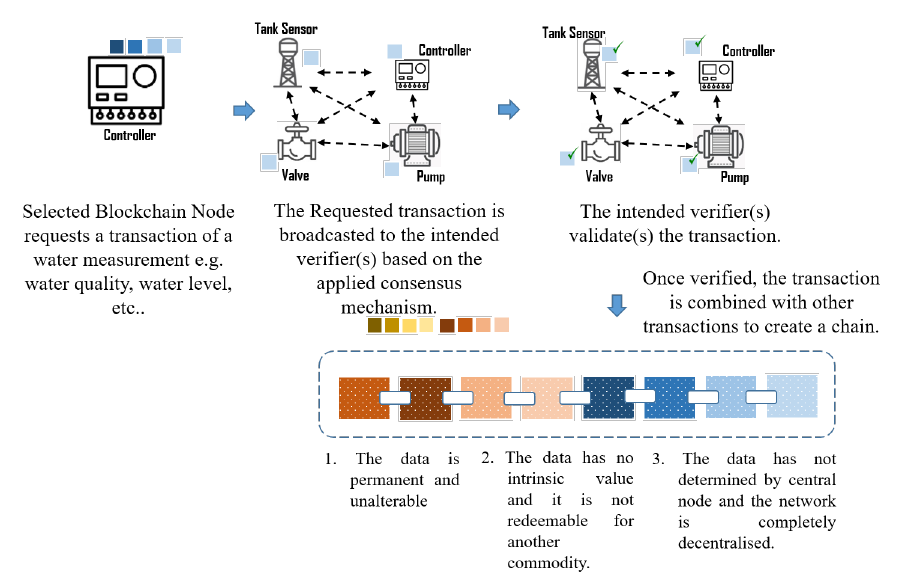
Figure 1. Blockchain